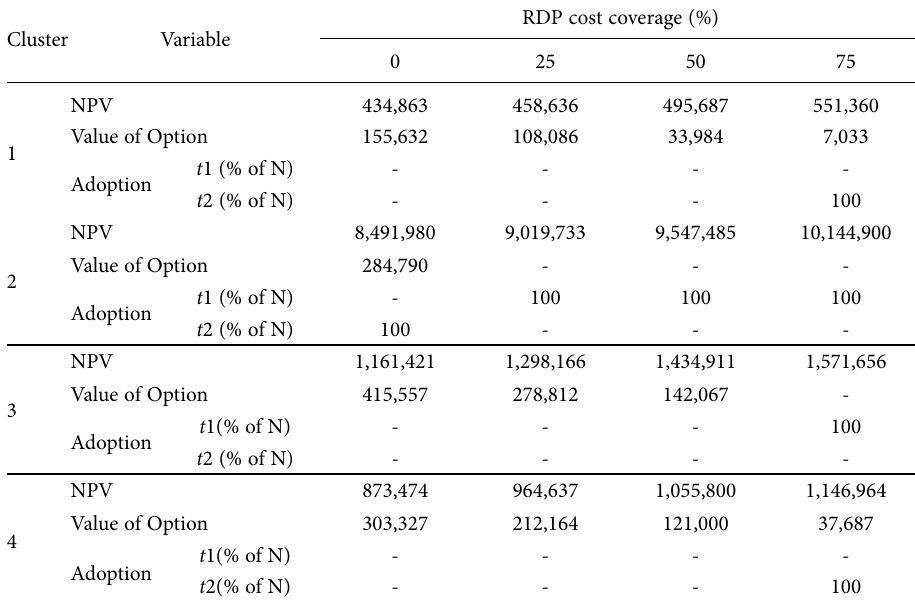
Table 6. Results with uncertainty in SFP (€ per